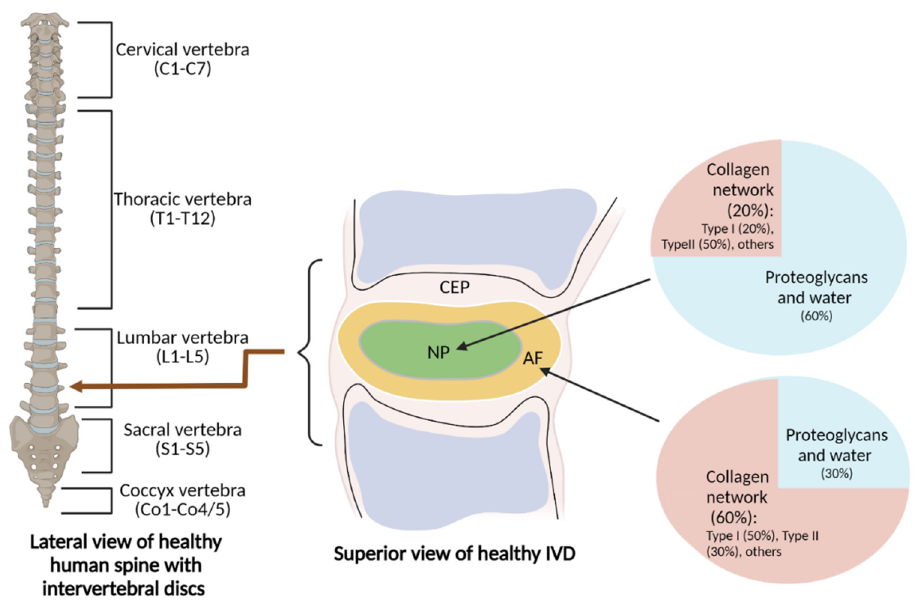
Figure 1. The major components of intervertebral discs. Intervertebral discs (IVDs) are located across the cervical, thoracic, lumbar, sacral, and coccygeal regions of the spinal column. IVDs consist of a central NP (nucleus pulposus), outer AF (annulus fibrosus) area, and interdependent and structurally connected CEP (cartilaginous endplate). The region-specific ECM structures, which include the proteoglycan-rich NP and collagen-rich AF, are maintained by separate cell populations.